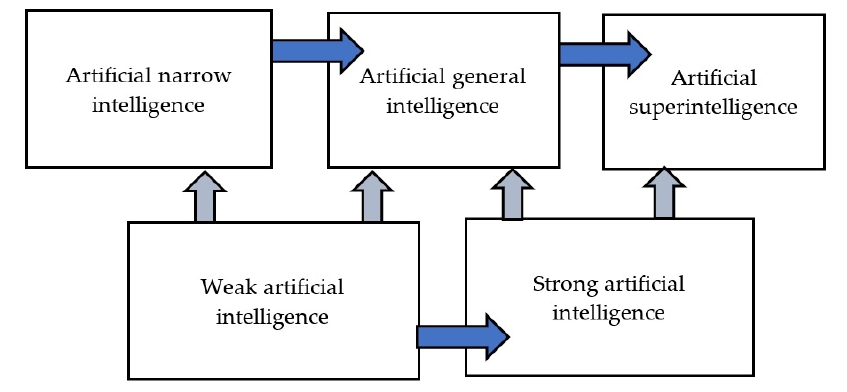
Figure 1. Stages in the evolution of artificial intelligence (own).